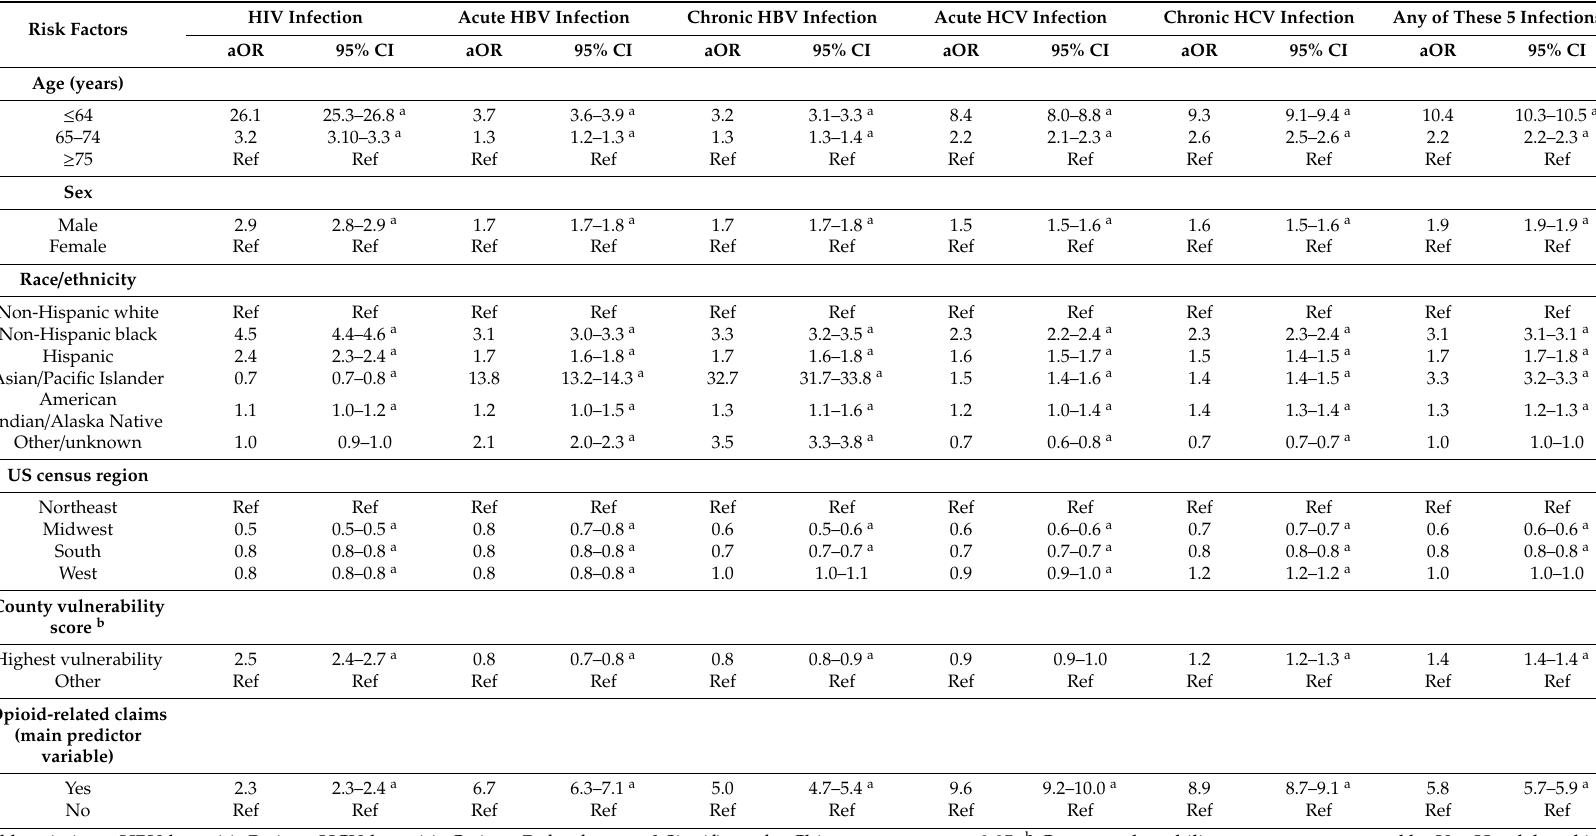
Table 3. Adjusted odds ratios (aORs) and 95% confidence intervals (CIs) for association of claims for HIV, HBV, or HCV infections with non-overdose opioid-related claims or each demographic attribute of Medicare beneficiaries, United States,